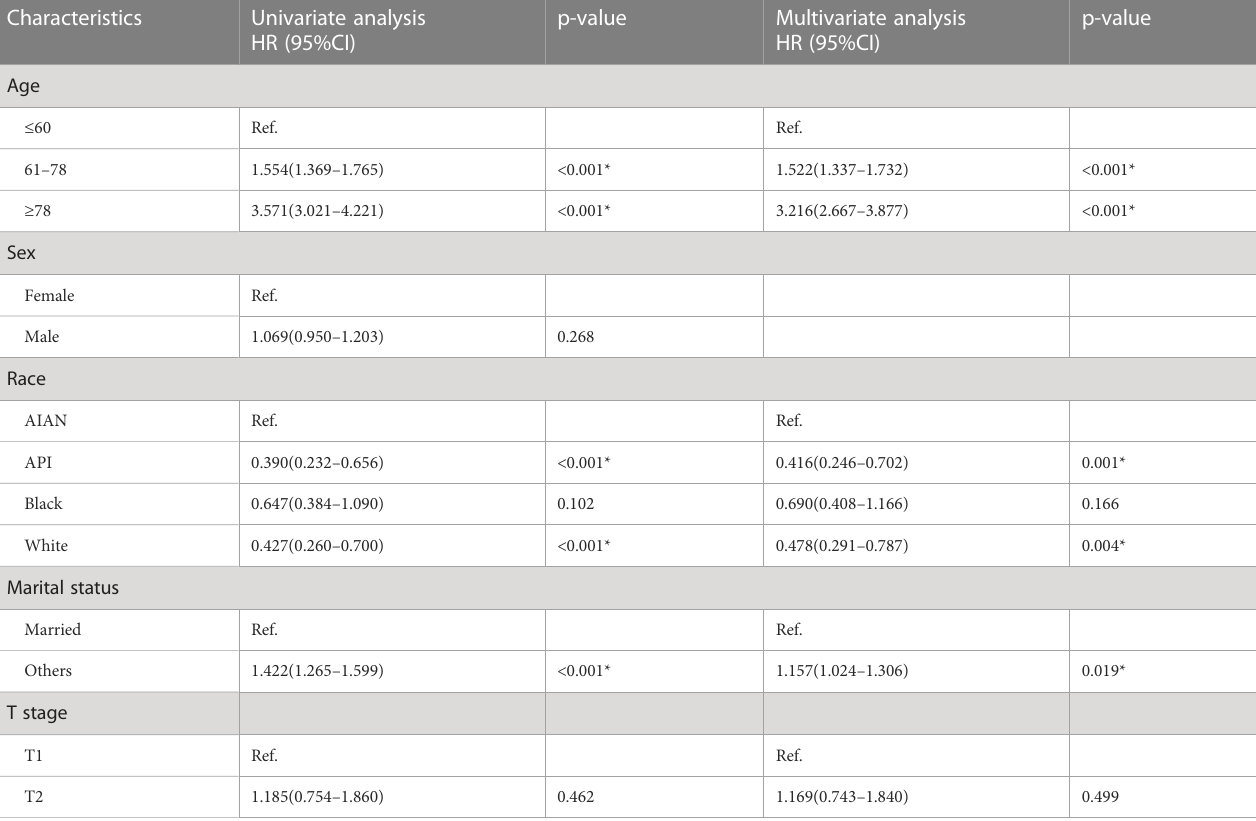
TABLE 2 Univariate Cox regression analysis and multivariate Cox regression analysis of CSS in the development cohort.